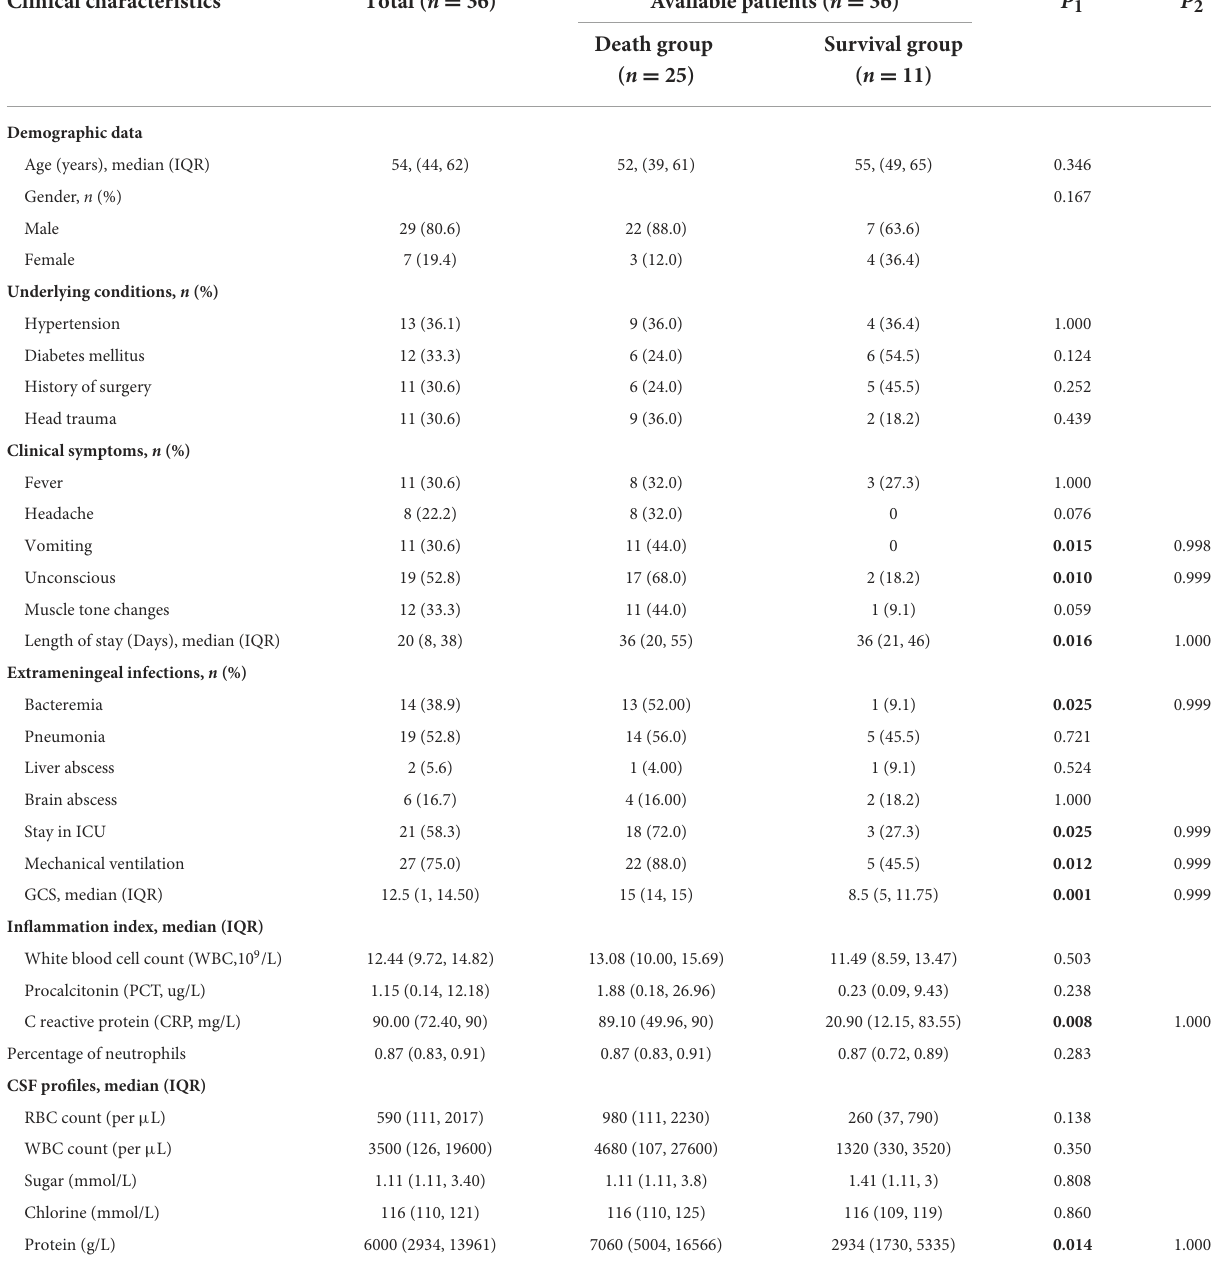
TABLE 1 Clinical characteristics of the 36 K. pneumoniae meningitis cases. Clinical